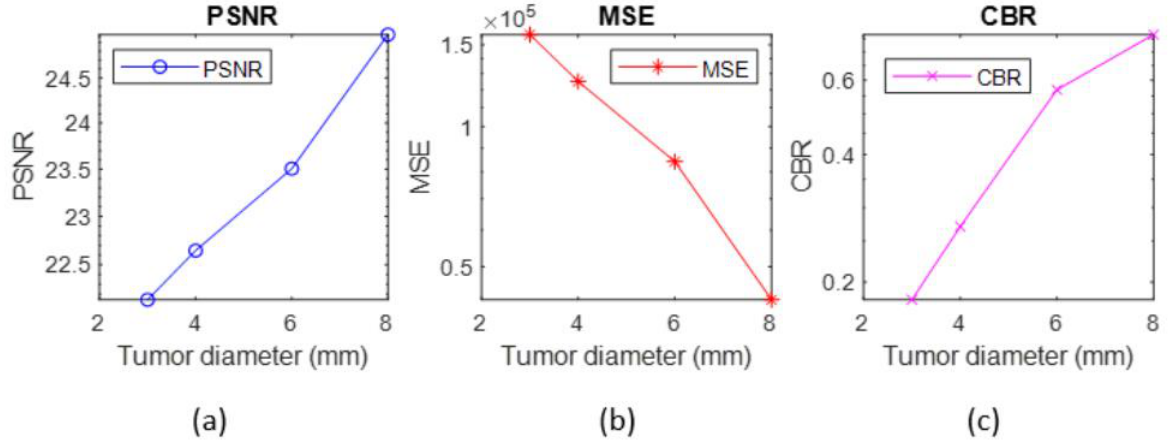
Figure 10. Breast phantom reconstructed images with ( a ) peak signal-to-noise ratio, ( b ) mean square error, ( c ) contrast-to-background ratio. error, ( c ) contrast-to-background